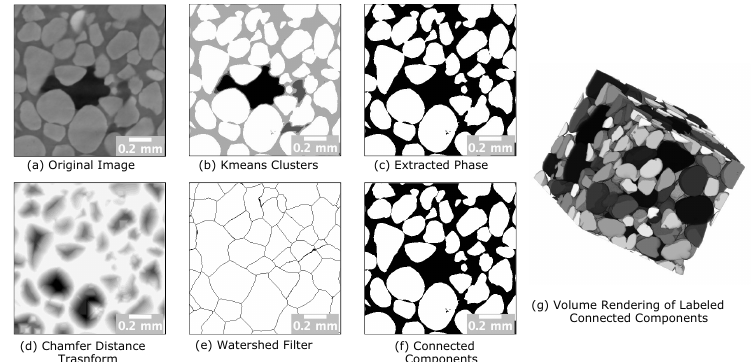
Figure 8. Example of applying connectivity component analysis. ( a ) The original image of the "sand in brine" data set. ( b ) Applying k-means clustering with 4 classes to explore phases of interest. ( c ) Binary image representing the extracted phase of interest using a masking. ( d ) Chamfer distance transform with H-Minima filter of threshold = 4 ( c ). ( e ) Morphological Watershed Filter applied ( d ). ( f ) Extracting connected components from the Watershed filtered image. ( g ) Volume rendering representing the labelled connected components (Blobs); 286 objects were found. The light gray phase corresponds to the sand grains (quartz), the dark gray phase corresponds to the brine, and the darkest gray corresponds to